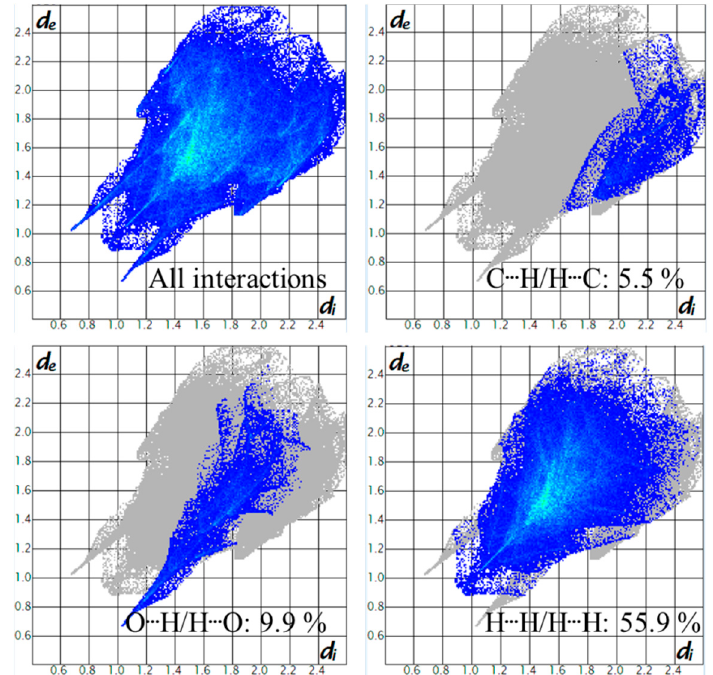
Figure 5. Hirshfeld surface analysis of the Ni(II) complex by d norm , d i , and d e mapping.